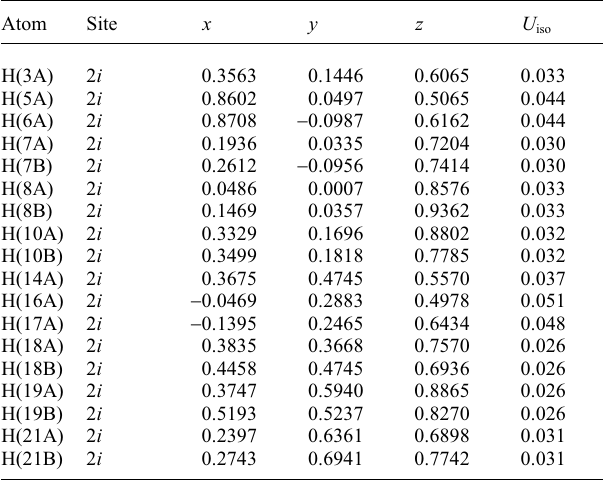
Table 2. Atomic coordinates and displacement parameters (in Å 2 )